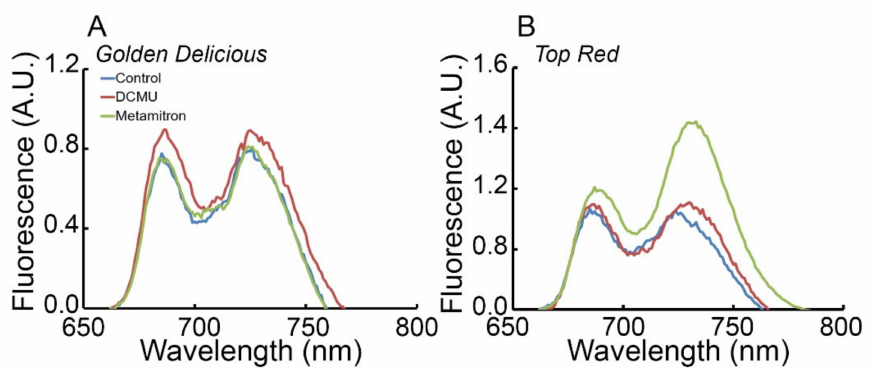
Figure 4. The 77K fluorescence spectra of apple tree leaves of two cultivars experiencing photosyn- thetic inhibition by Metamitron. Panels ( A , B ) represent Golden Delicious and Top Red cultivars, respectively. There are three treatments in each panel-control (only buffer), 3-(3,4-dichlorophenyl)-1,1- dimethylurea (DCMU), 4-Amino-4,5-dihydro-3-methyl-6-phenyl-1,2,4-triazin-5-one (Metamitron) in colors of Blue, Magenta and Green, respectively. Each curve is an average of three biological repeats.